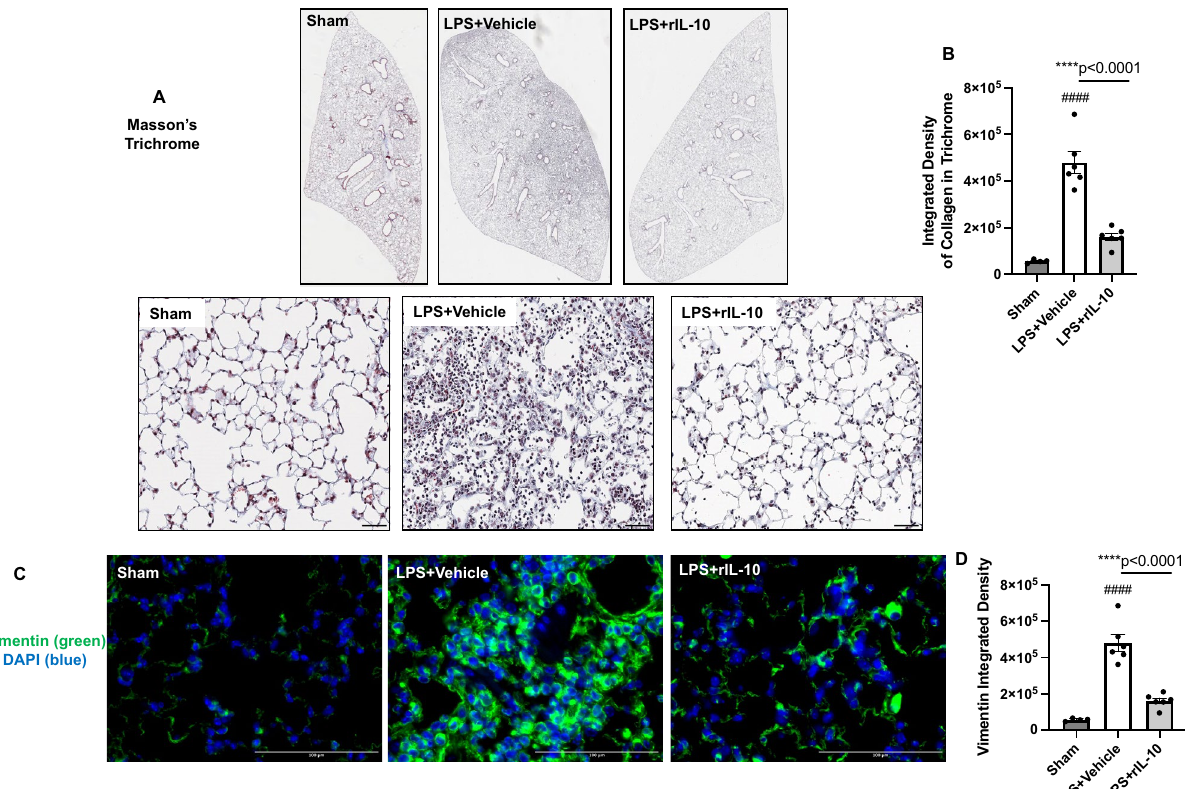
Figure 7. Treatment with rIL-10 reduces lung collagen and vimentin expression following a one-time high dose LPS exposure. Representative Masson’s trichrome lung section images from both treatment groups and sham (saline control) ( A ) with integrated densities from deconvoluted trichrome images as measure of collagen content ( B ) shown. Confocal images of lung tissues stained for vimentin (green) ( C ) with nuclei staining by DAPI (blue) and integrated density of vimentin ( D ) quantified per each mouse. Individual values are averaged from 8 to 10 images per section per mouse. Statistical significance vs. sham (####p < 0.0001). Asterisks (****p < 0.001). Line scale is 100